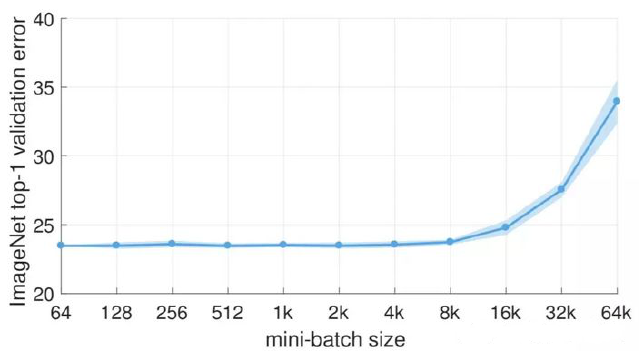
Figure 13. Batch size versus model